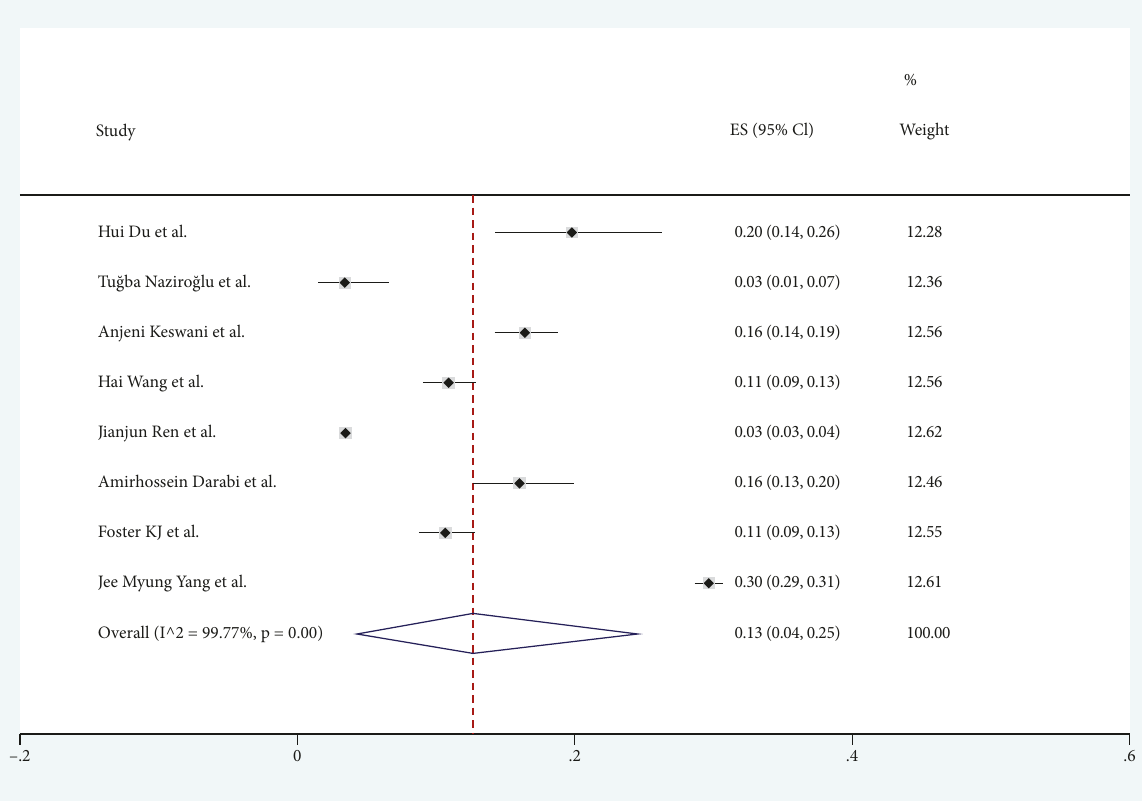
Figure 2: Meta-analysis of AR in COVID-19 cases of stay forest plot.